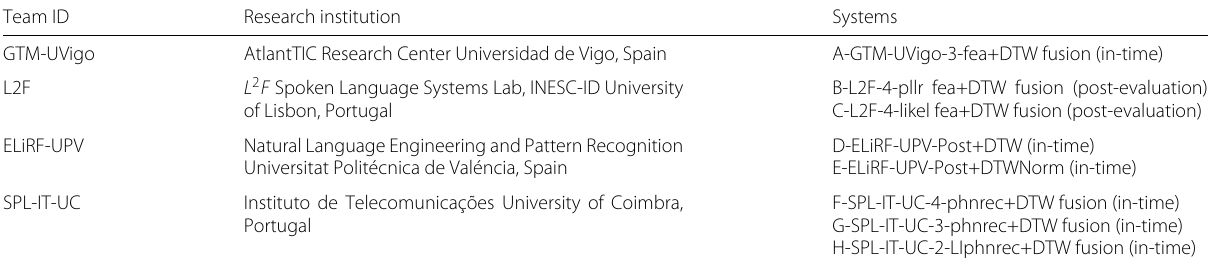
Table 5 Participants in the ALBAYZIN QbE STD 2016 evaluation along with the submitted systems Team